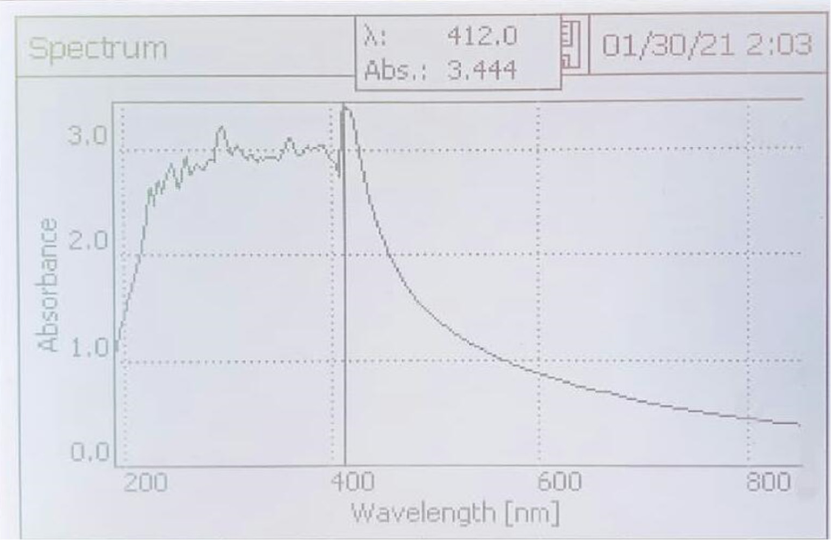
Figure 7. Ultraviolet–visible spectral analysis of synthesized silver-nanoparticles (Ag NPs) using A. indica leaf extract.